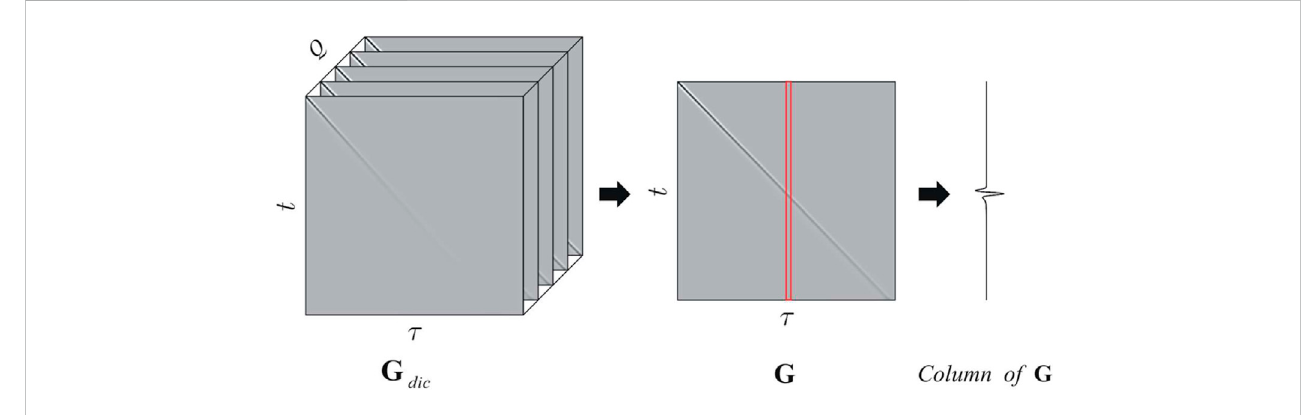
FIGURE 2 The structure of the dictionary